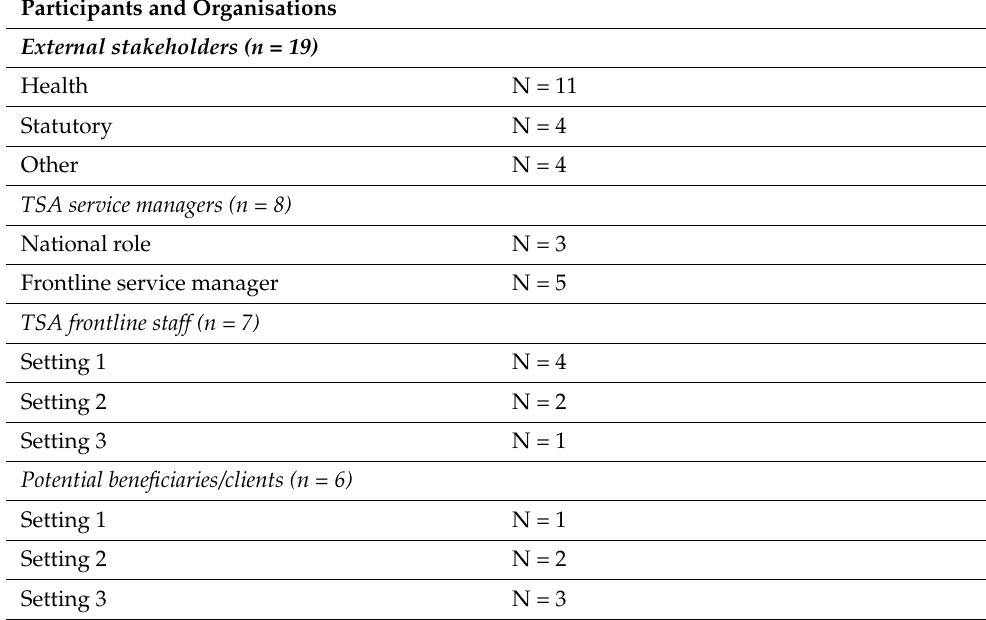
Table 1. Participant